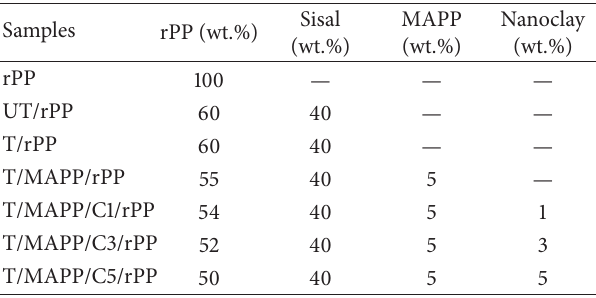
Table 3: Sample name and the various compositions of SF/rPP